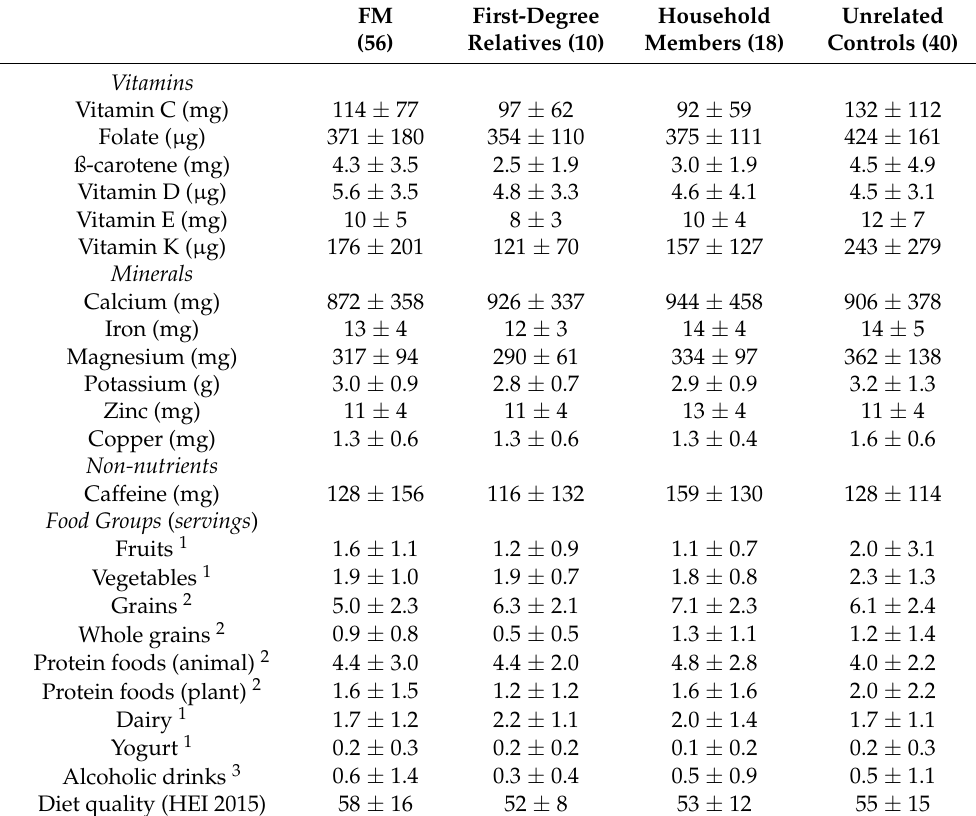
Table 3. Intake of selected micronutrients and food groups, and healthy eating